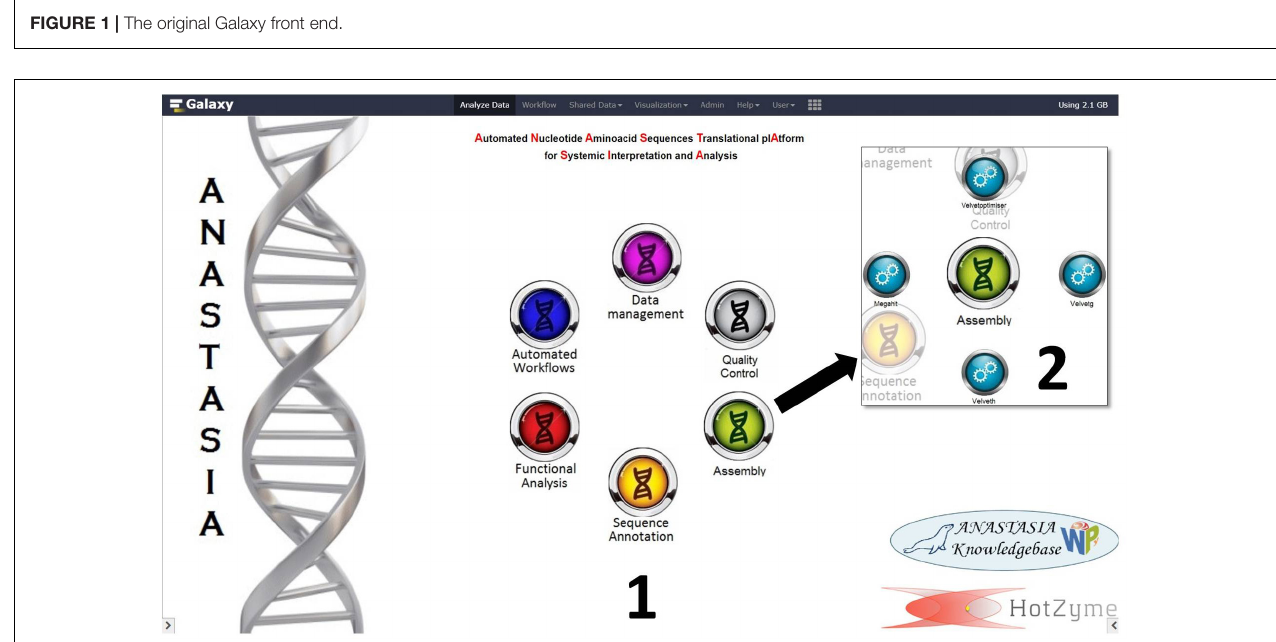
FIGURE 1 | The original Galaxy front end.